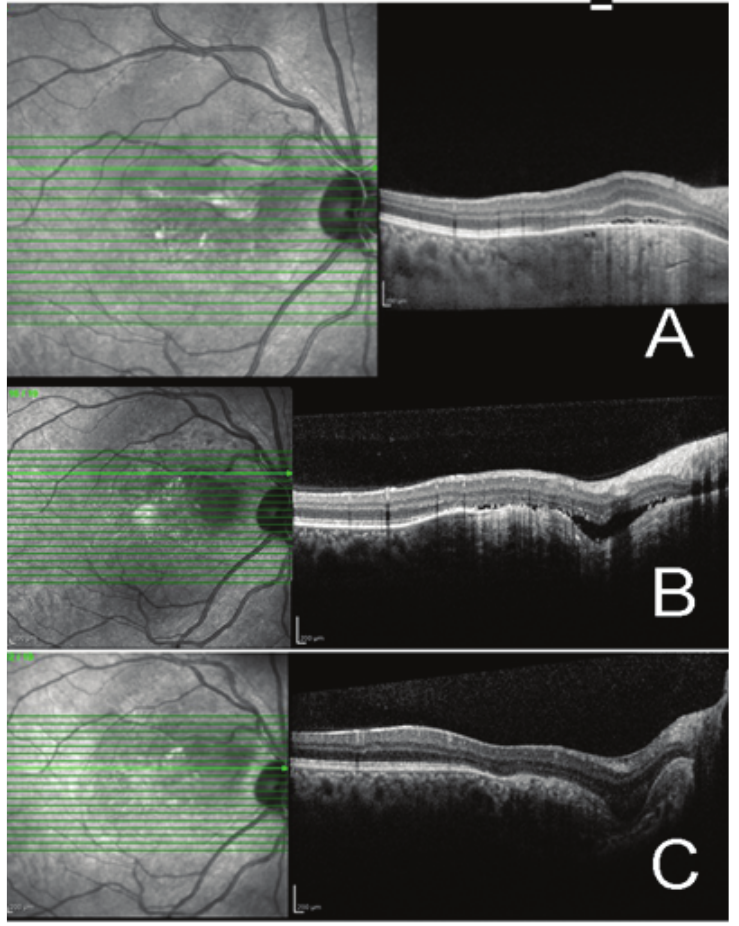
Figure 2. SD- OCT of the right eye: (A) Spectral-domain OCT (SD-OCT) of the right eye performed in 2014 revealed subretinal fluid (SRF) associated with choroidal osteoma complicated by choroidal neovascularization (CNV). (B) OCT of the right eye (2016) clearly shows focal choroidal excavation and SRF due to CNV development. (C) OCT of the right eye clearly shows FCE and complete resolution of SRF after two consecutive intravitreal bevacizumab